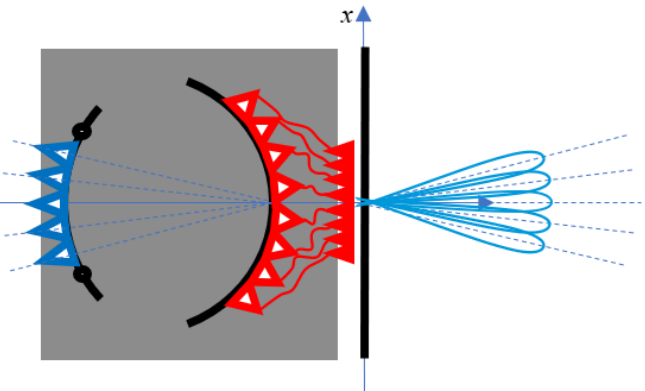
Figure 5. Discrete lens with back array larger than the front array. It exhibits an increased field of view but a larger volume.